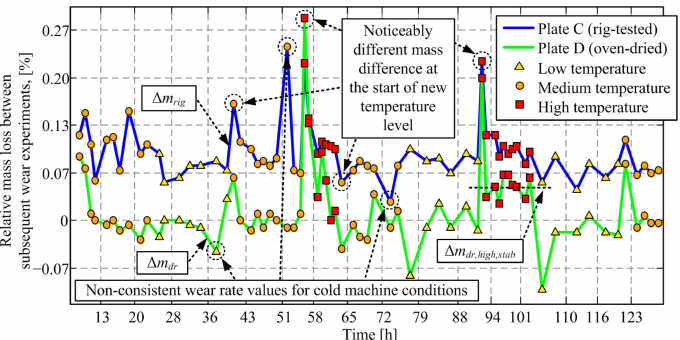
Figure 8. Comparative time responses of mass loss between subsequent wear experiments for friction Plates C and D (derived from Figures 6 and 7, with omitted Non-dried and Drying @ 100 ◦ C